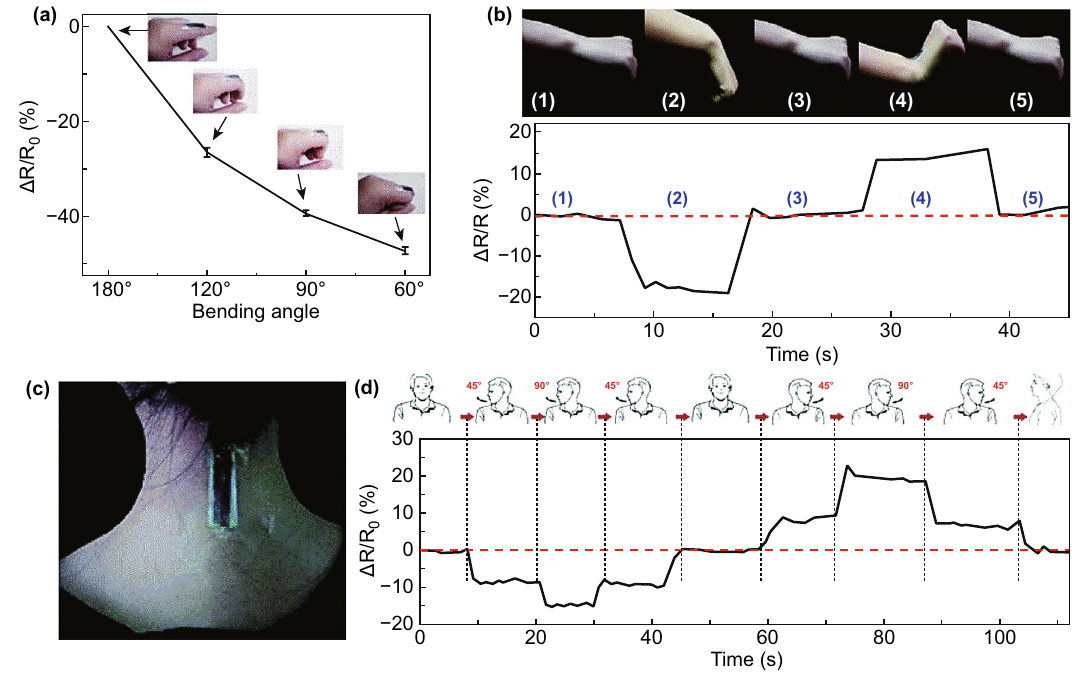
Fig. 26 a – d Electrical resistance changes of multifunctional NCs-GO hybrid film sensor attached to different parts of the human body to detect and monitor various human motions of the human forefinger, wrists up-downward, and head rotation (0°–45°–90°) under multidirectional motions, separately. Reproduced with permission from Ref. [165] Copyright © 2018, The Royal Society of